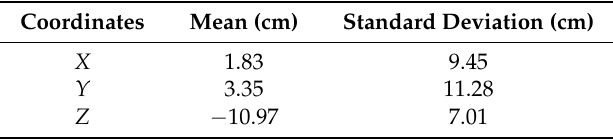
Table 2. Position error statistics.